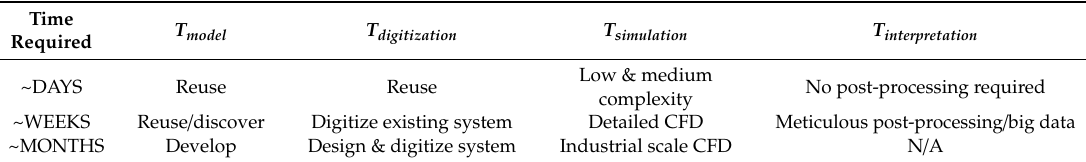
Table 2. Order-of-magnitude analysis of required time for M&S per